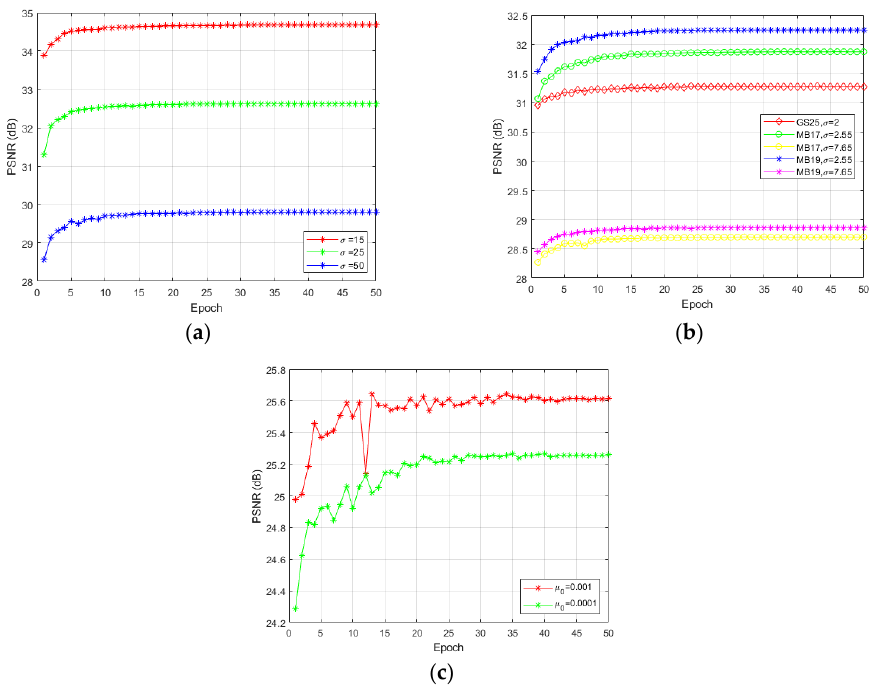
Figure 2. PSNR (dB) during the training epochs of three applications. ( a ) Three Gaussian denoising experiments. ( b ) Five image deblurring experiments. ( c ) Two FlatCam imaging experiments.